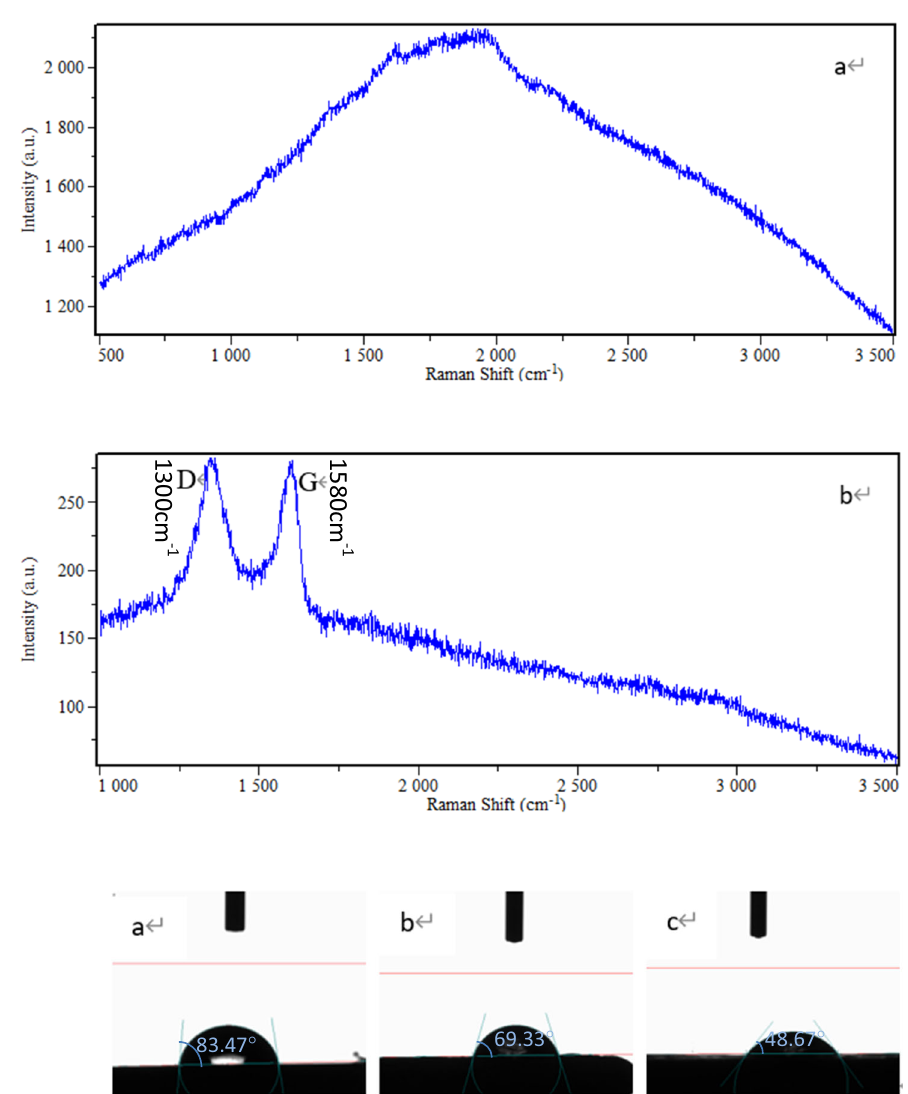
Fig. 4 Raman spectra of PEEK and SPEEK-GO. ( a ) PEEK; ( b ) SPEEK-GO. The D-band and the G-band peaks are the characteristic Raman peaks of carbon-based crystals that appear in the vicinity of 1300 cm − 1 and 1580 cm − 1 , respectively